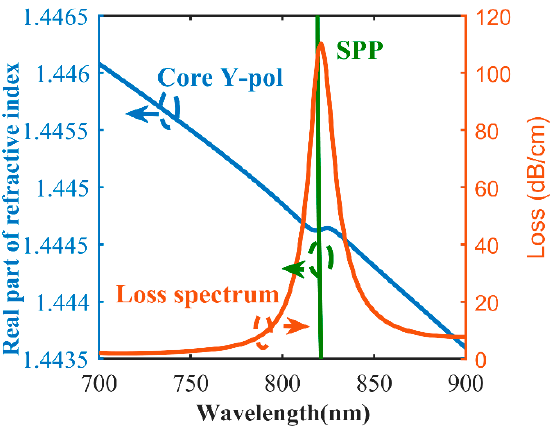
Figure 5. Real part of effective refractive index of the y-polarized fiber core mode and surface plasmon polariton (SPP) mode, and the loss spectra of the PCF-SPR sensor when the material of the metal layer is gold.